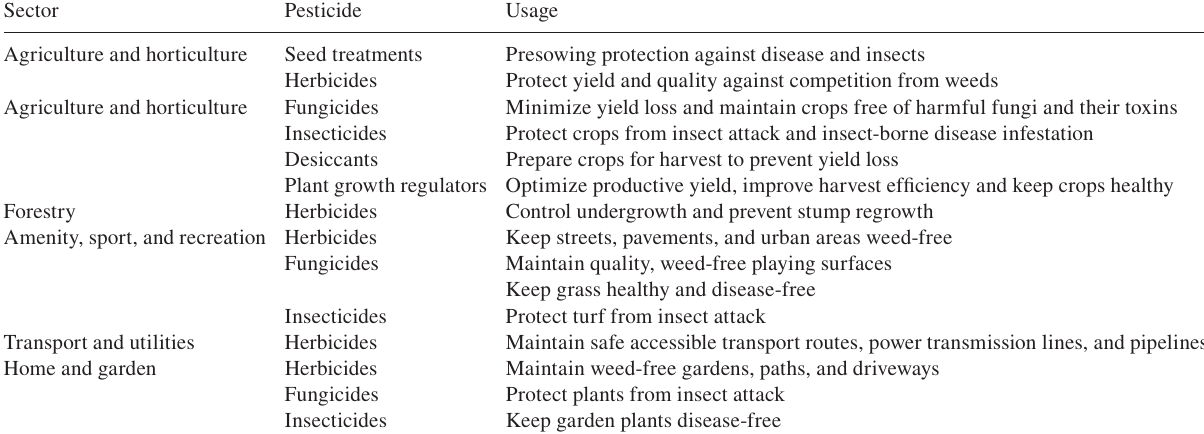
Table 1 Usages of pesticides.